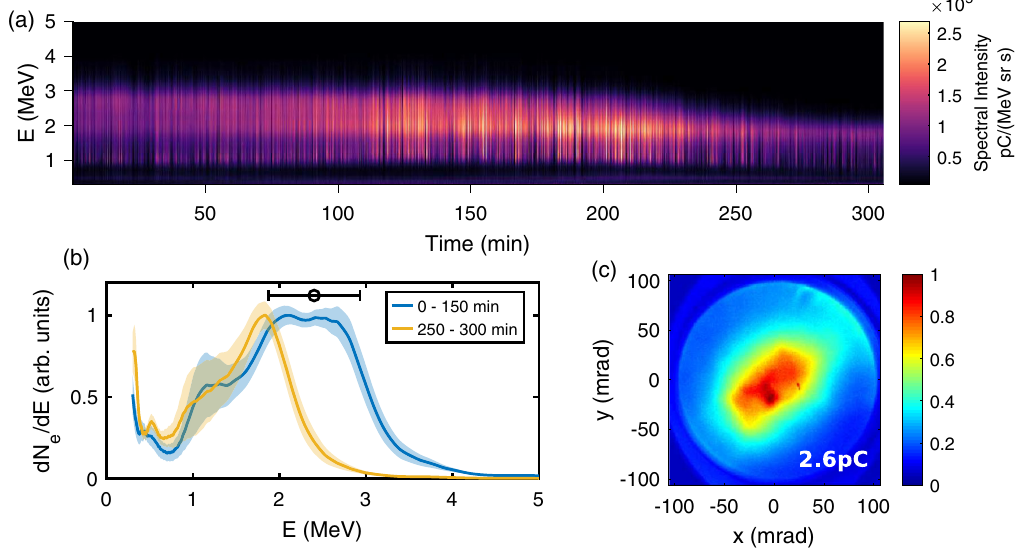
FIG. 3. (a) Electron spectra measured continuously for 306 min. Each spectrum is averaged over 100 shots. (b) Electron spectra averaged over 0 – 150 min (blue) and 250 – 300 min (orange), and their standard deviations (shaded area); the black error bar represents the spectrometer resolution at 2.4 MeV. (c) Electron beam measured just before the start of the 5h spectrum monitoring. The total charge per shot is 2 . 6 pC (cid:2) 0 . 6 pC (std). The beam divergence is approximately 80 mrad